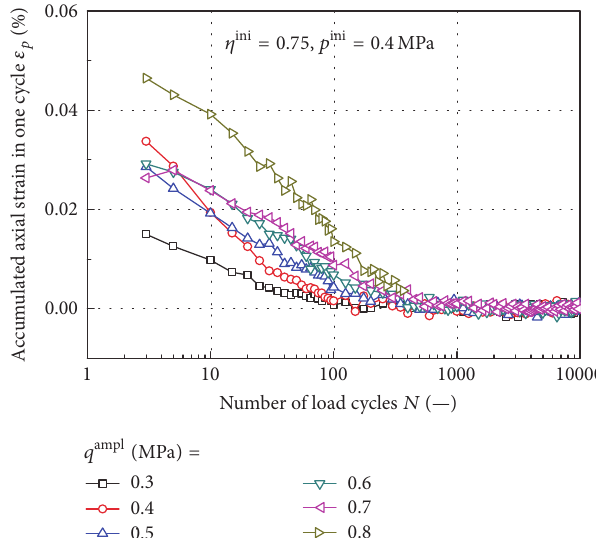
Figure 11: The development of individual permanent strain versus number of load